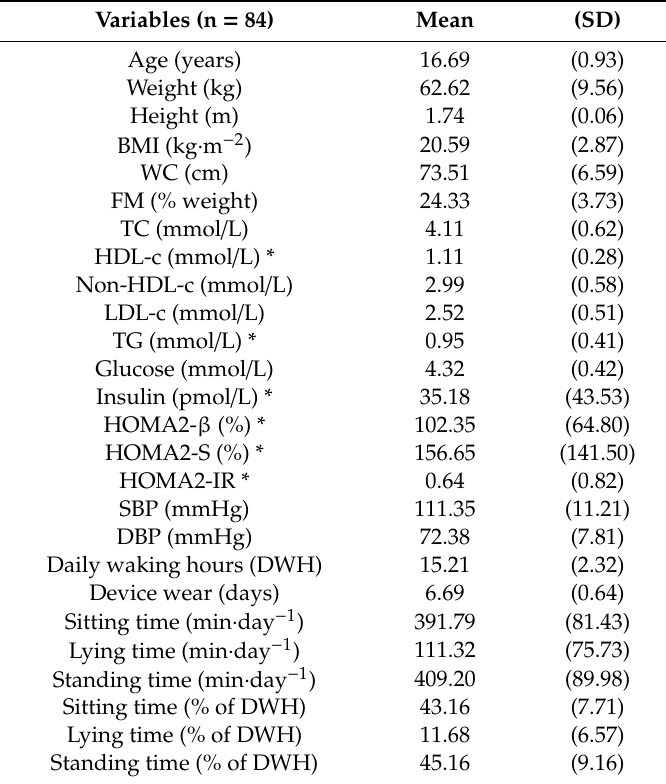
Table 1. Descriptive characteristics of